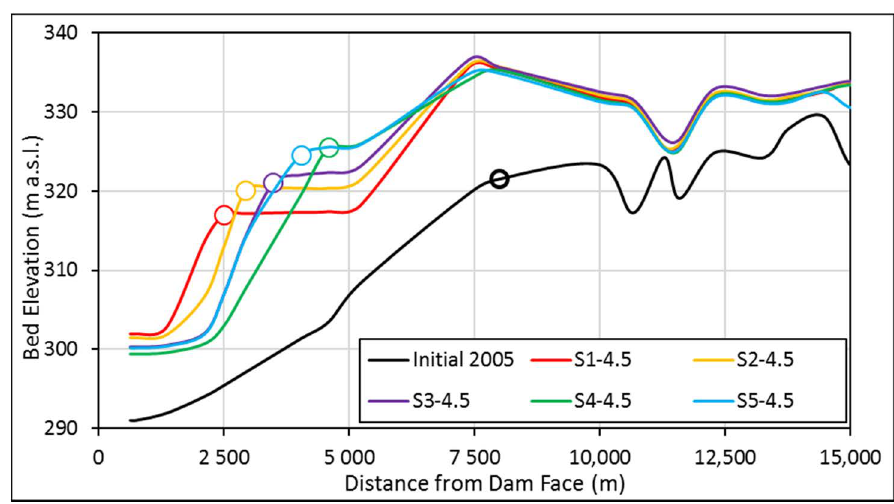
Figure 14. Bed profile of the deposited sediment for S1-45 scenario.